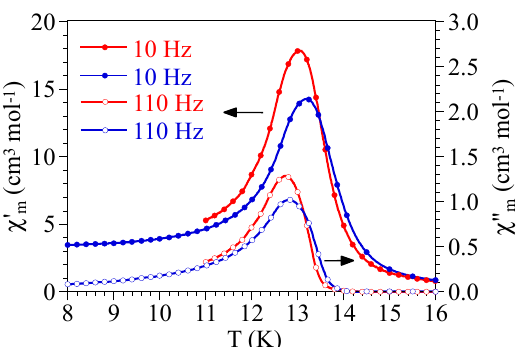
Figure 8. Thermal variation of the in-phase ( χ′ m , left scale, filled circles) and out-of-phase ( χ″ m , right scale, empty circles) signals of compound 1 at two different frequencies.